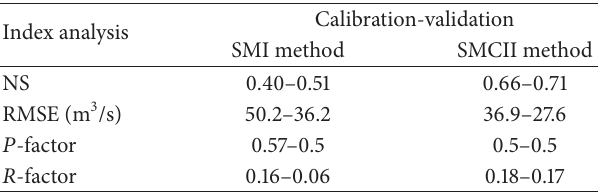
Table 3: Values of the indices used for the evaluation of the models’ accuracy during model calibration and validation.